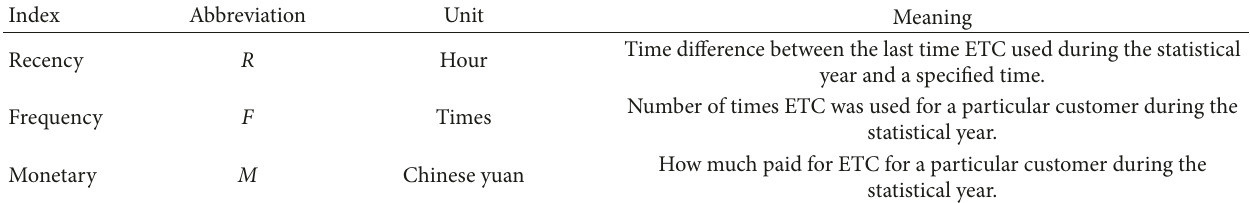
Table 2: Segmentation index of ETC